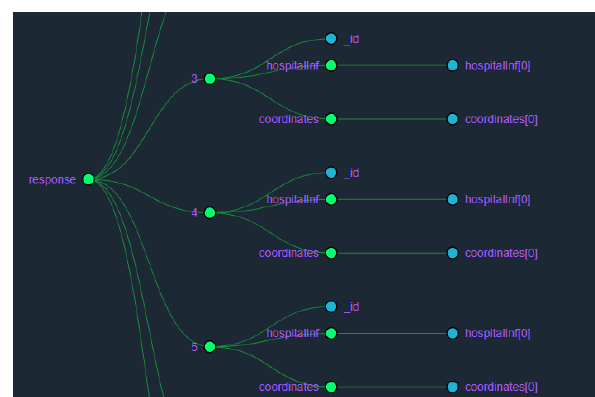
Figure 5: The result of web service 3: Get all coordinates of hospitals (chart